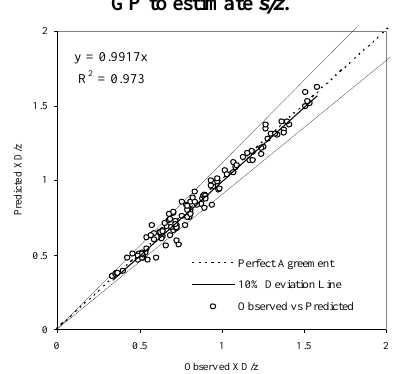
Figure 8. Comparison between observed and predicted GP to estimate XS/z .